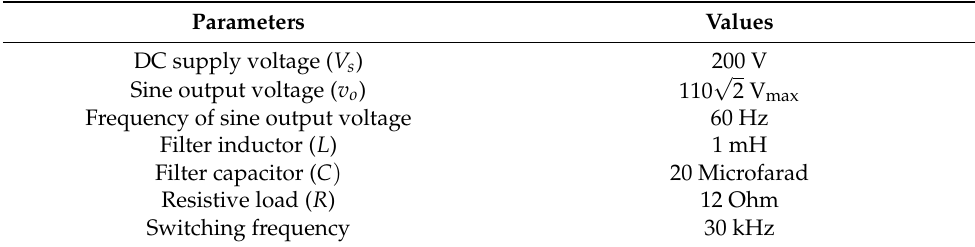
Table 1. Parameters of the single-phase SPWM